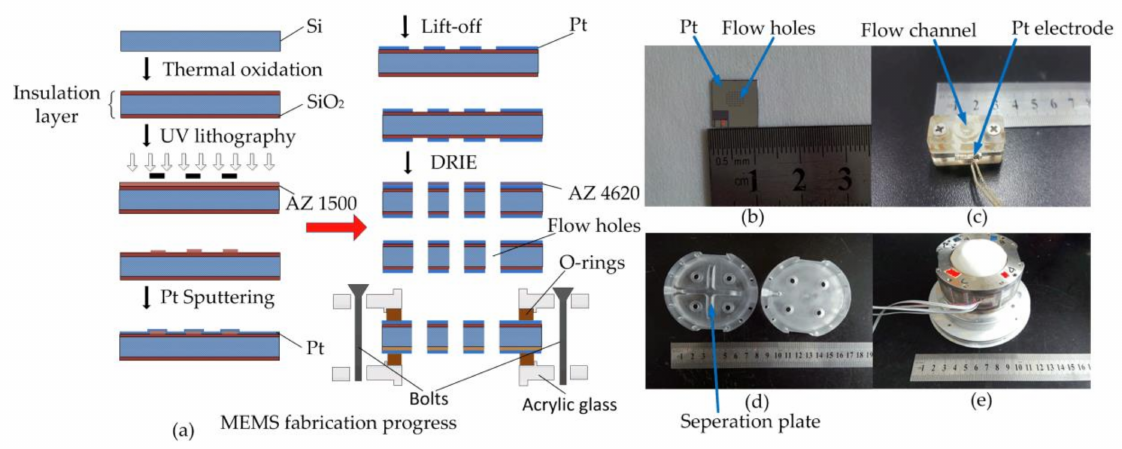
Figure 5. ( a ) The fabrication progress of the electrodes in sensing units, including thermal oxidation, Pt sputtering, lift-off and deep reaction ion etching. ( b ) The electrode fabricated by MEMS technology with a lot of flow holes. ( c ) The sensing unit composed by electrodes and flow channels. ( d ) The acrylic glass housing with separation plate and flow channels. ( e ) The assembled